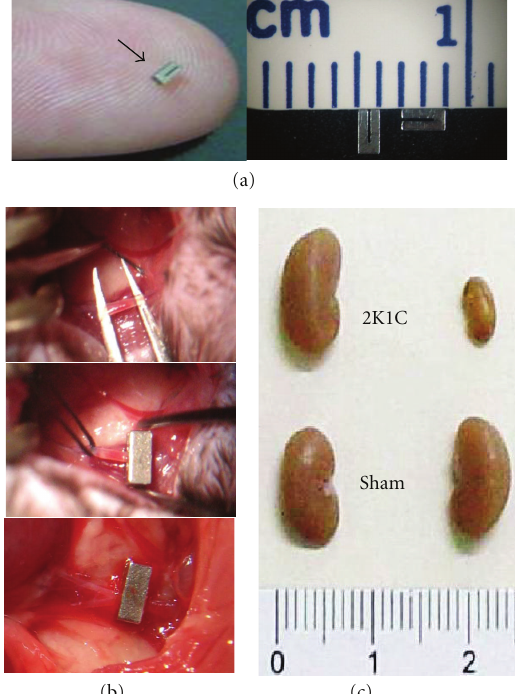
Figure 1: The procedure used to induce angiotensin-dependent hypertension in the mouse. A solid, stainless steel clip with an opening width of 0.12mm (a) is placed around the left renal artery to cause stenosis (b), which results in the atrophy of the clipped kidney and hypertrophy of the contralateral, nonclipped kidney (c) and hypertension. Table 1: Cardiovascular parameters in 2K1C mice compared to Sham mice, two weeks after clipping. Parameter Sham 2K1C Reference no. Mean arterial pressure (mmHg) Heart rate